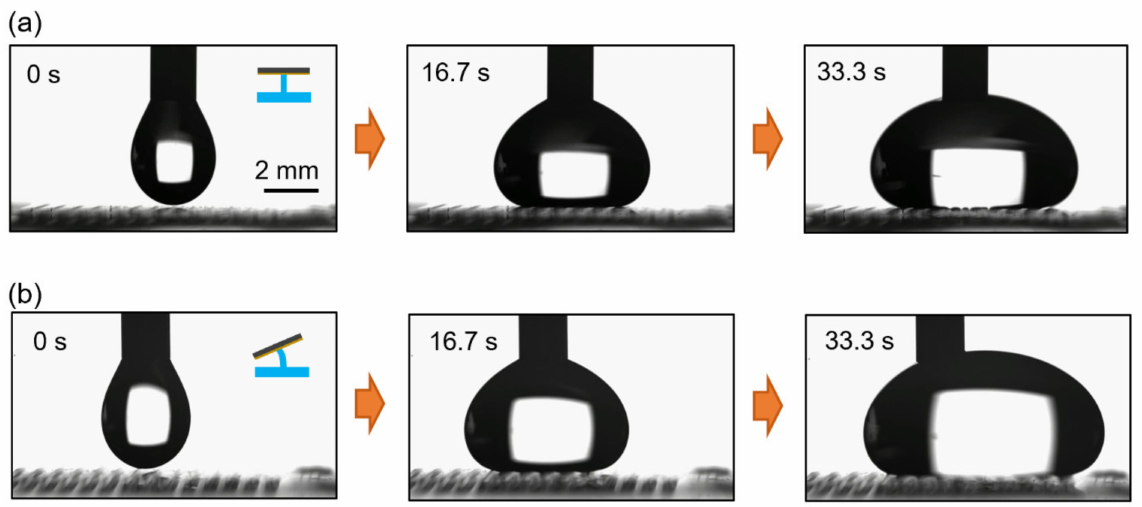
Figure 8. ( a ) Symmetric spreading behavior of a water droplet when no magnetic field is applied and black silicon strips are flat. ( b ) Asymmetric spreading behavior of a water droplet when a magnetic field is applied and black silicon strips form a ratchet